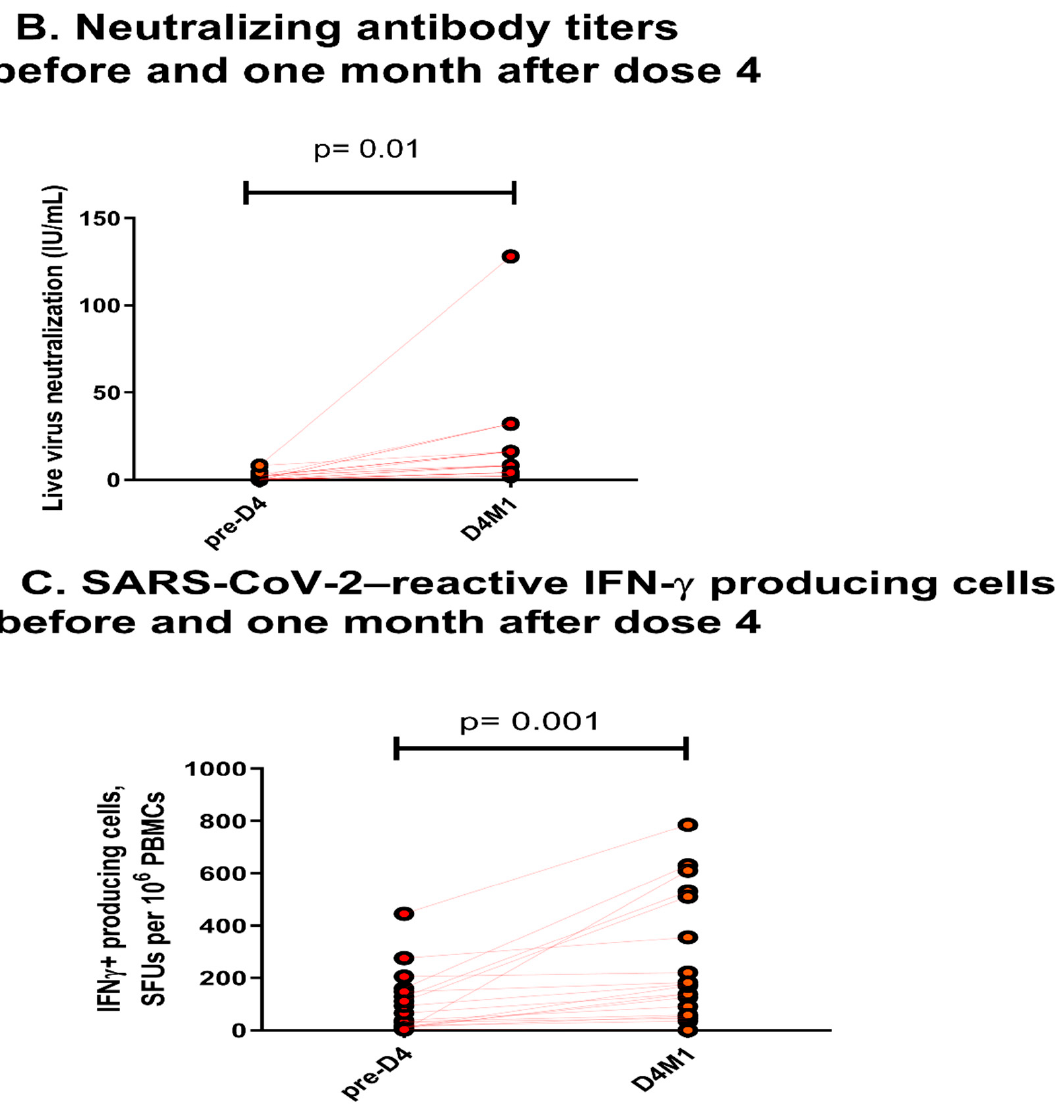
Figure 1. ( A ). Total anti–SARS-CoV-2 antibody concentration before and one month after the fourth dose. Data are expressed in binding antibody unit (BAU)/mL. p values were derived from Student’s paired t -test. The solid lines indicate the medians. ( B ). Neutralizing antibody titers before and one month after the fourth dose. Data are expressed as the reciprocal of the highest serum dilution protecting cells from a cytopathic effect. The solid lines indicate the medians. ( C ). The numbers of cells reactive to overlapping peptide pools spanning SARS-CoV-2 structural protein S (pools S1 and S2). Data are expressed by spot-forming units (SFUs) per 10 6 peripheral blood mononuclear cells (PBMCs). The solid lines indicate the